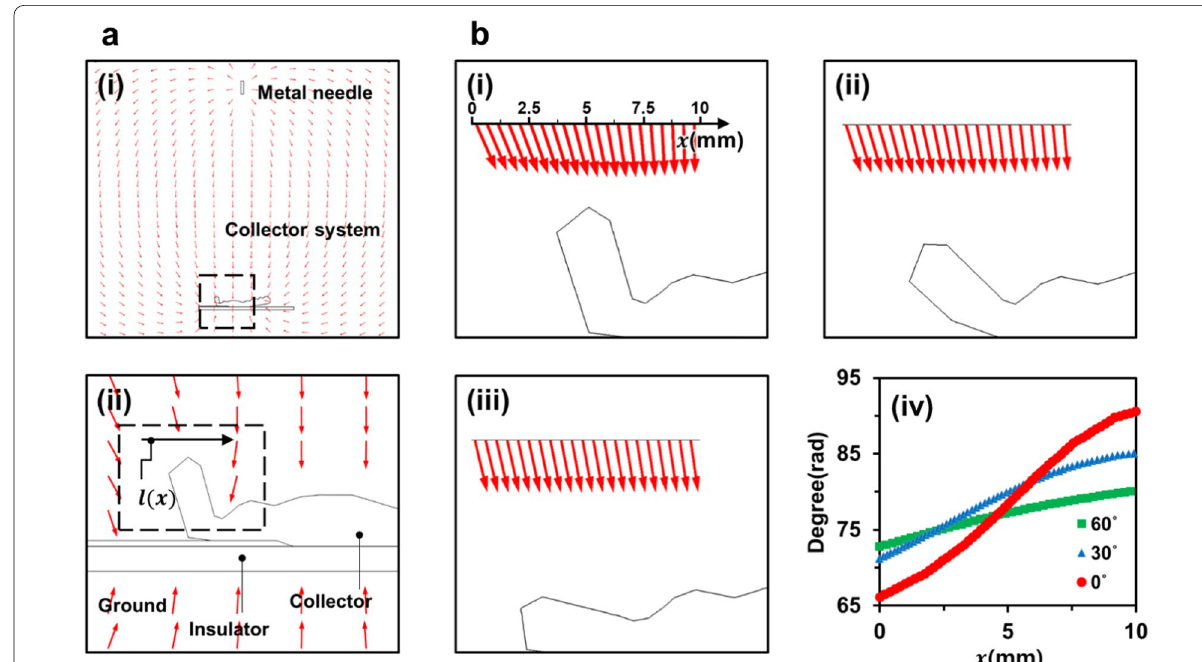
Fig. 4 Electric field simulations for the hydrogel collector ( a -(i)) and a magnified image of the dashed rectangular in a -(i) ( a -(ii)). ( b ) The dashed rectangular in a -(ii) showing the recessed region of the hydrogel collector. The electric field arrows along the reference line l ( x ) with the bending angles of 0° ( b -(i)), 30° ( b -(ii)), and 60° ( b -(iii)). b -(iv) The angle of the electric field to the 3D ear cartilage-shaped hydrogel collector with the bending angle of 0°, 30°, and 60° along the reference line l ( x